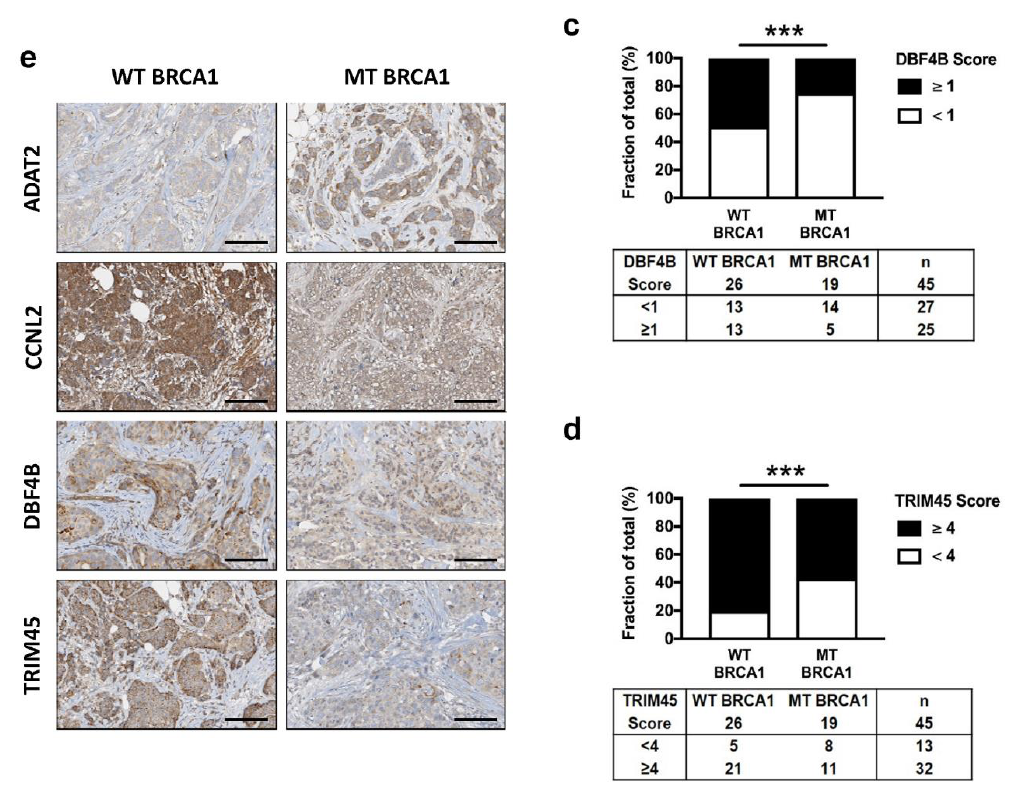
Figure 5. Altered expression of ADAT2, CCNL2, DBF4B, and TRIM45 proteins in BRCA1 deficient human breast cancers. ( a – d ) Score of ADAT2 ( a ), CCNL2 ( b ), DBF4B ( c ), and TRIM45 ( d ) in breast cancer samples of 45 patients (exploratory cohort): 26 patients non-mutated (WT BRCA1) and 19 patients mutated (MT BRCA1) for BRCA1. For ADAT2, a validation cohort of 13 BRCA1 mutated patients (MT BRCA1 validation) was additionally analyzed. Stacked bars represent the fraction of total tumor samples (expressed in %) from a tissue microarray (TMA) with low (white bar) and high (black bar) scores. Results of Chi-square test are indicated by NS = non-significant; ** p < 0.01; *** p < 0.001. Corresponding number of samples are presented under histograms. ( e ) Representative TMA immunohistochemical images demonstrating differential ADAT2, CCNL2, DBF4B, and TRIM45 staining between BRCA1 mutated (MT BRCA1) and BRCA1 non-mutated (WT BRCA1) tumors. Scale bars = 100 µm.